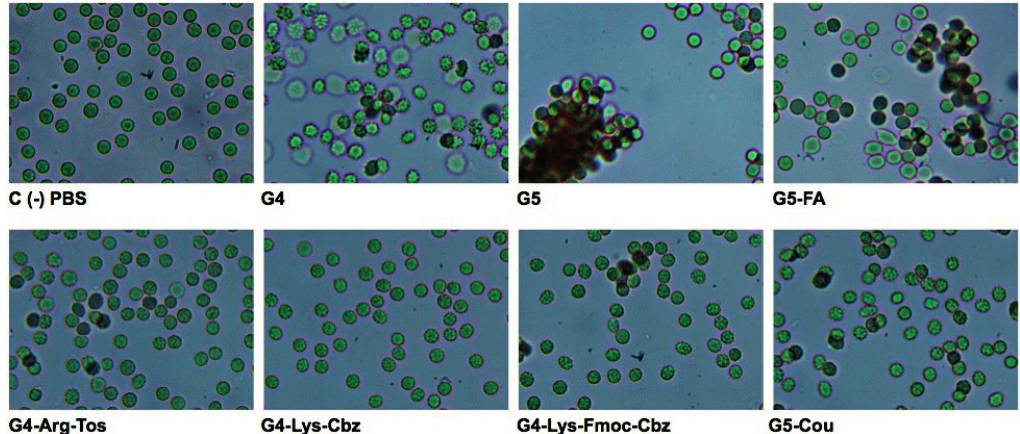
Figure 4. Optical microscopy (400×) of different dendrimers incubated at a concentration of 4 µM, with 2% ( v / v ) of washed